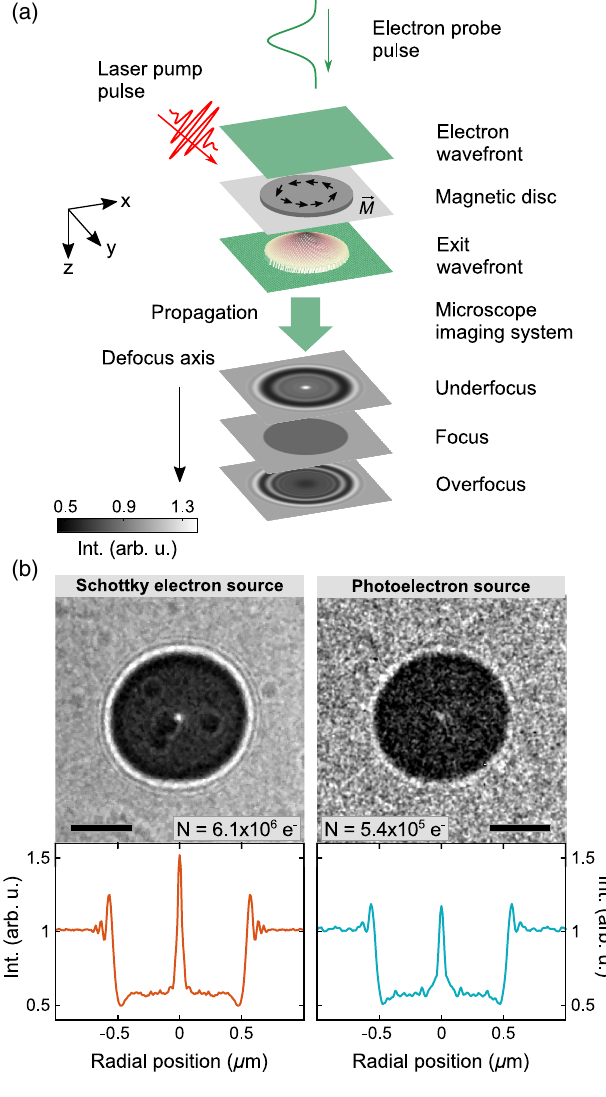
FIG. 1. Femtosecond Lorentz microscopy. (a) Scheme of experimental setup and Lorentz image formation. (b) Lorentz micrographs of the permalloy disc using a continuous Schottky emission (left) and laser-triggered photoemission (right) recorded with the same microscope conditions ( − 1 . 5 -mm defocus). The number of electrons contributing to each image is indicated. Total illuminated area is about 25 μ m in diameter. Profiles in the lower panels show the azimuthally averaged intensity of the corresponding micrographs. Scale bars represent 500